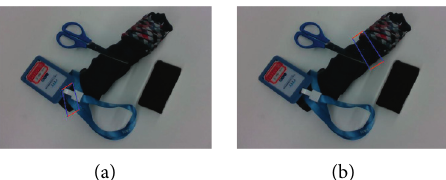
Figure 7: Comparsion of our matching algorithm with the original SIFT algorithm on household objects: (a) the result generated by the original SIFT algorithm; (b) the result obtained by our matching algorithm. Our matching algorithm decreases the influence of occluded parts and predicts a more suitable grasp configuration than the original SIFT